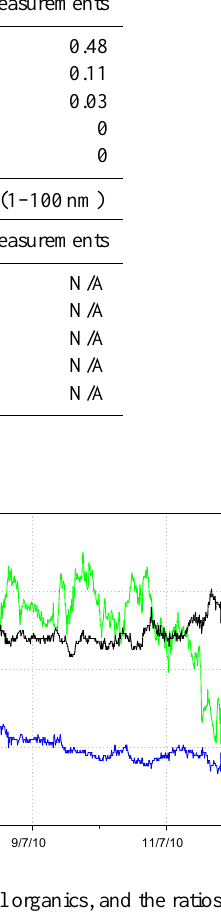
Fig. 12. Timeseries of AMS total organics, and the ratios of mass- to-charge 43 and mass-to-charge 44 to total organics measured at Raven’s